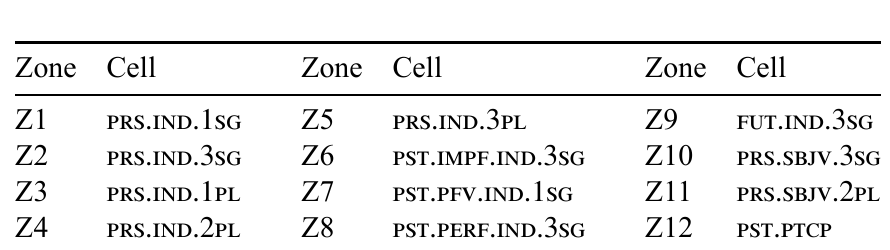
Table 18: A distillation of the European Portuguese conjugation paradigm